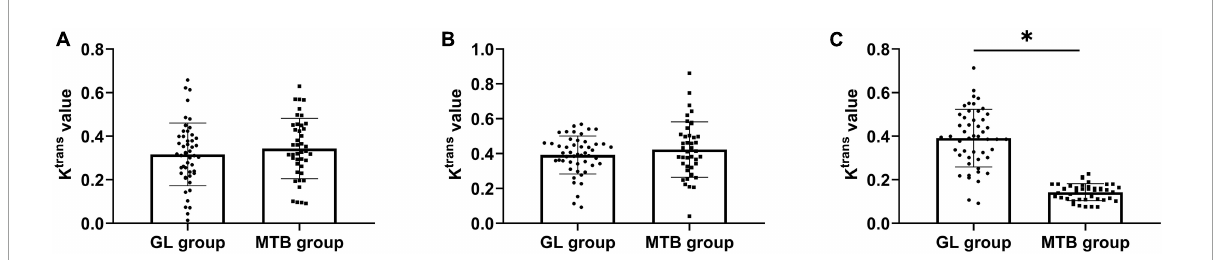
FIGURE5 Comparison of K trans values between patients with GL and MTB. (A) Comparison of K trans values of the tumor parenchyma area. (B) Comparison of K trans values of the tumor cystic area. (C) Comparison of K trans values of the peritumor edema area, * P < 0.05.